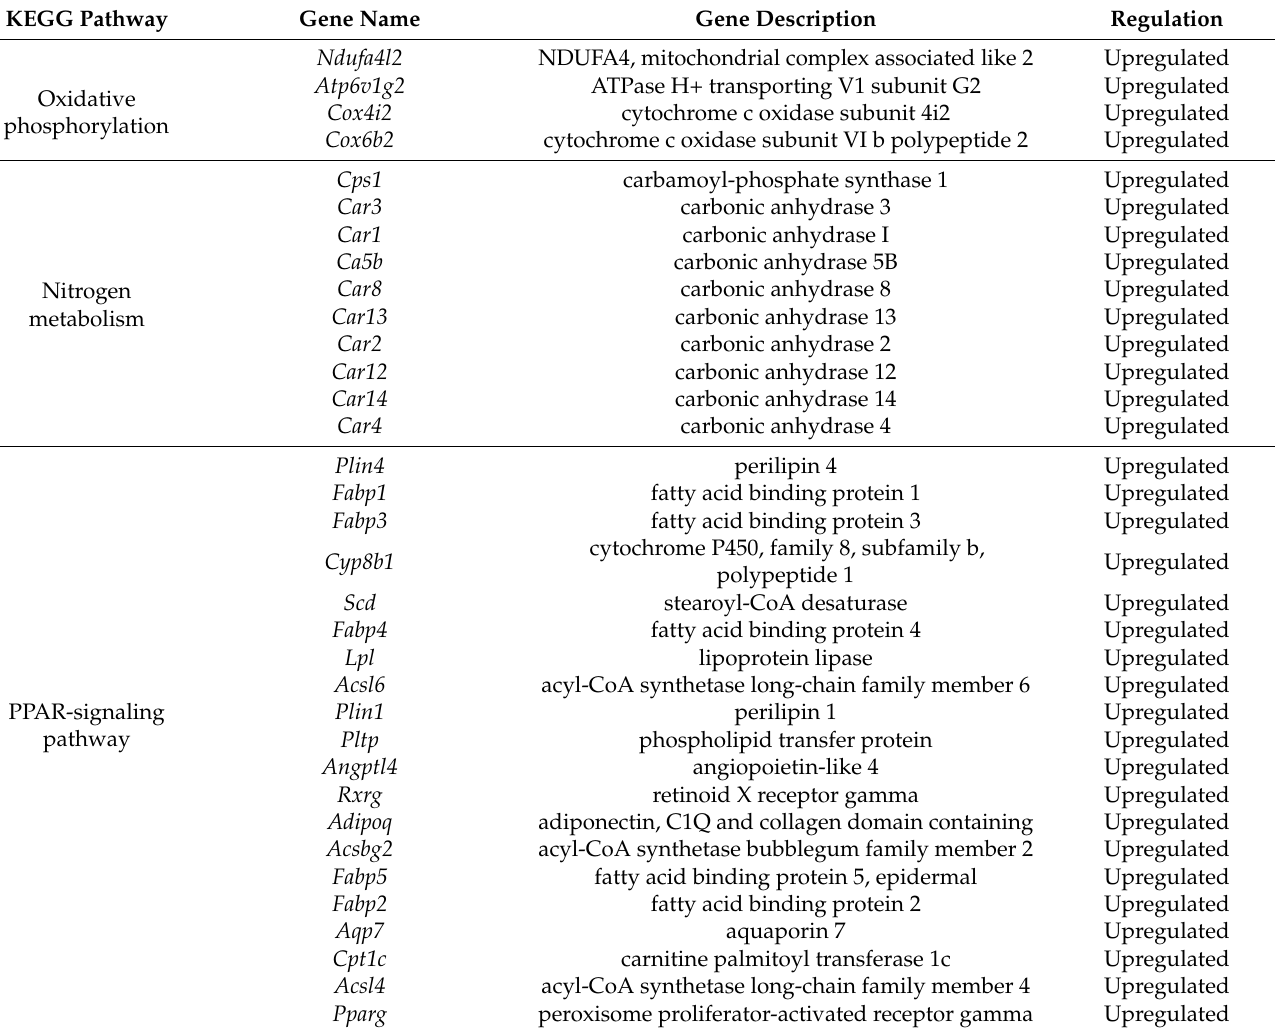
Table 3. Information of three KEGG pathways and DEGs